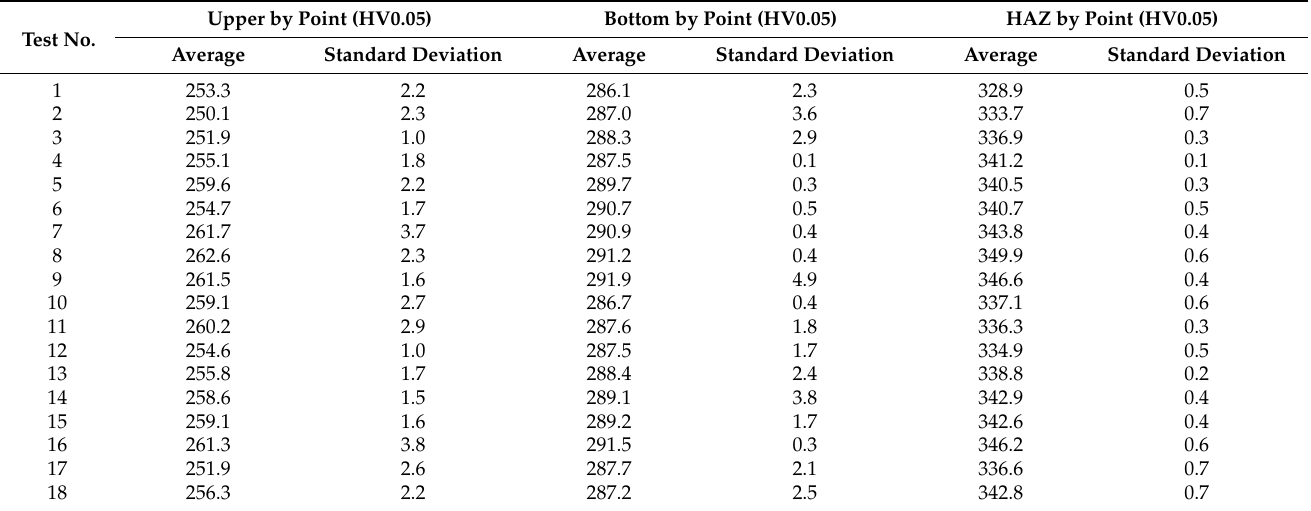
Figure 4. Schematic diagram of the hardness test. Table 6. Results of hardness according to welding process and parameters.